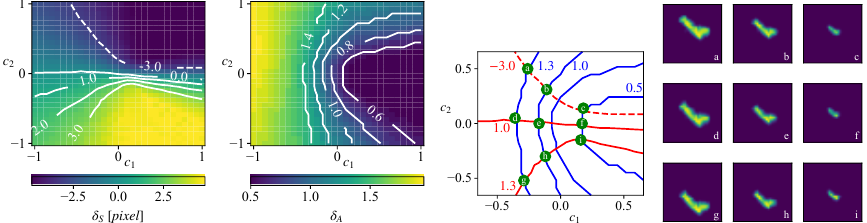
Figure 12. The relation between translation–scaling and two latent codes. The relation between translation angle δ S and c 1 , c 2 ( top-left ). The relation between scaling δ A and c 1 , c 2 ( top-right ). The overlapped curves of the above two contours as well as some selected intersections (green dots) ( bottom-left ). The synthesized SAR images with ( c 1 , c 2 ) corresponding to the coordinates of the green dots in the former contour ( bottom-right